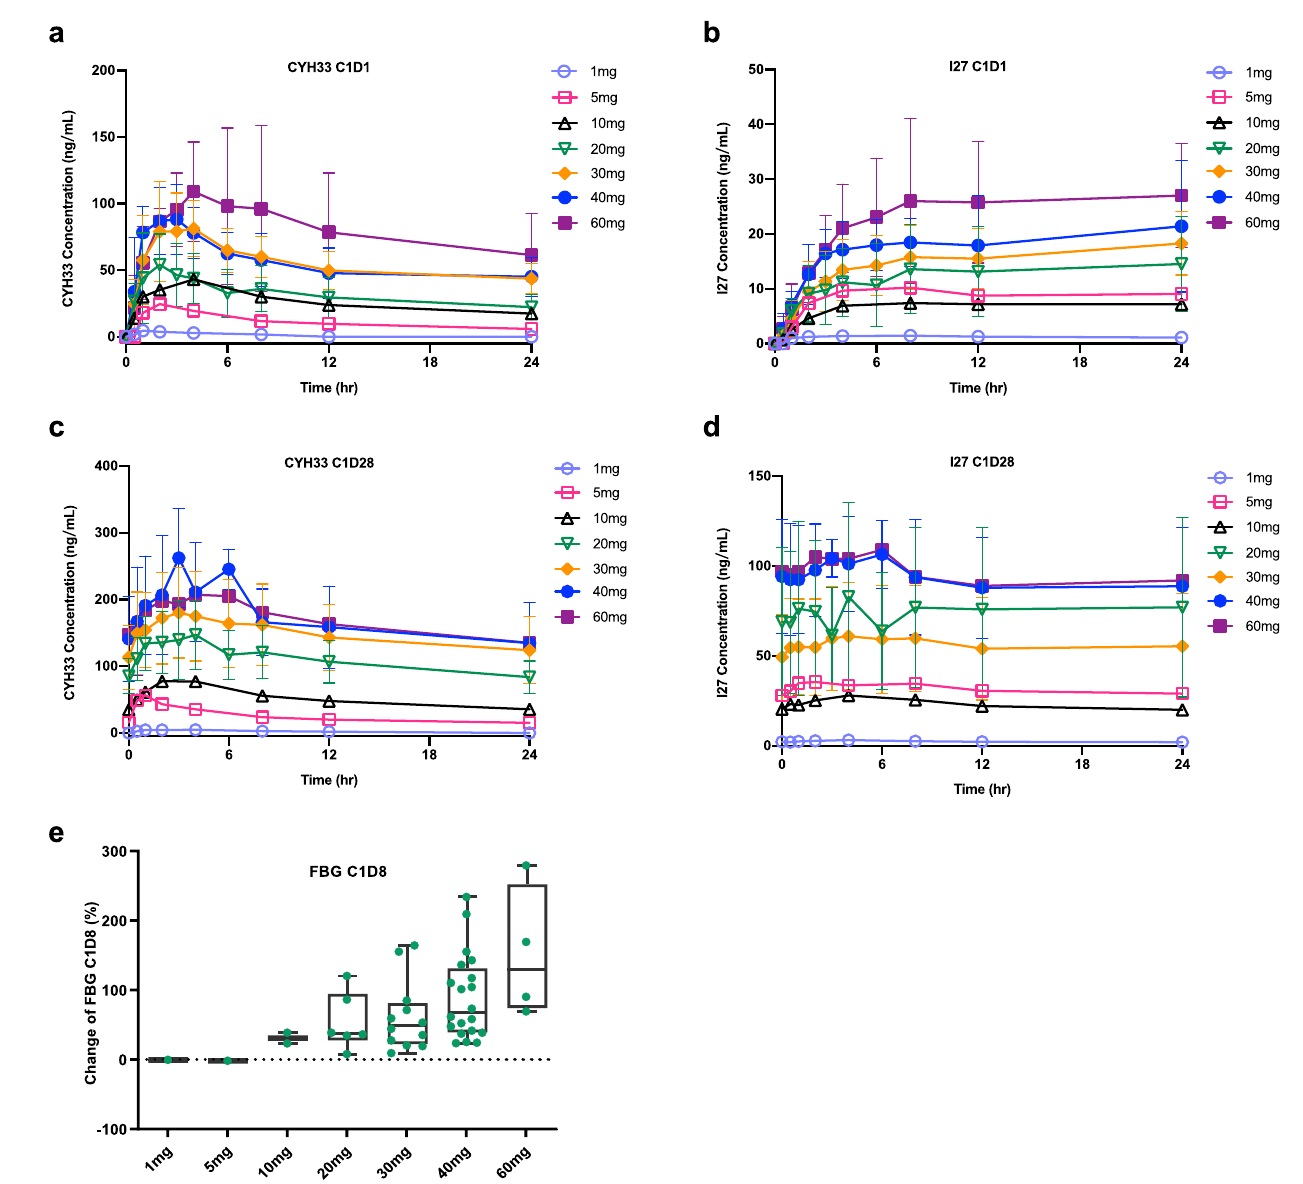
baseline on Cycle 1 Day 8 (1mg, n =1; 5mg, n =1; 10mg, n =2; 20mg, n =6; 30mg, n =12; 40mg, n =20; 60mg, n =4). The box represents 25th, 50th, and 75th per- centiles of observed values; the whiskers represent the minimum and maximum values; green dots represent individual values. hr hour, FBG fasting blood glucose, SD standard